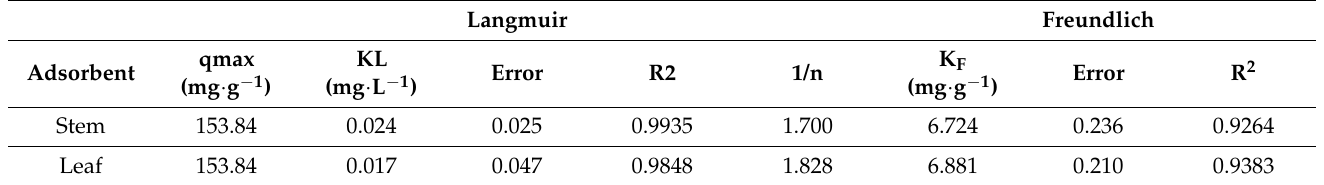
Figure 7. Linearized isotherm of ( a ) Langmuir and ( b ) Freundlich for the adsorption of stem biomass; linearized concentration isotherm of ( c ) Langmuir and ( d ) Freundlich for leaf biomass adsorption. Table 3. Constant of the isothermal models of the stem and leaf of water hyacinth ( Eichhornia Crassipes ) in the adsorption of the cationic dye methylene blue.